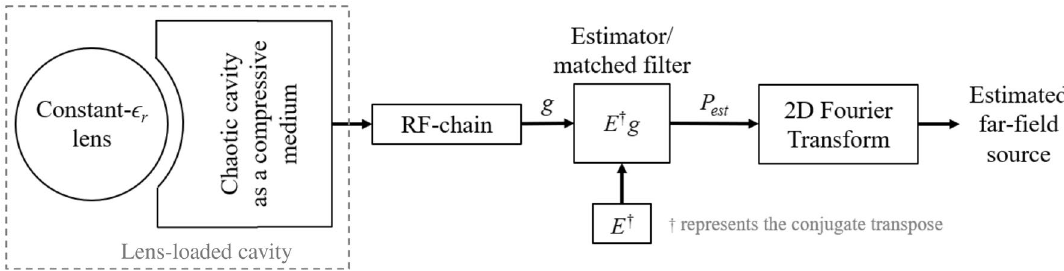
Figure 1. System block diagram with the lens-loaded cavity, RF and signal processing